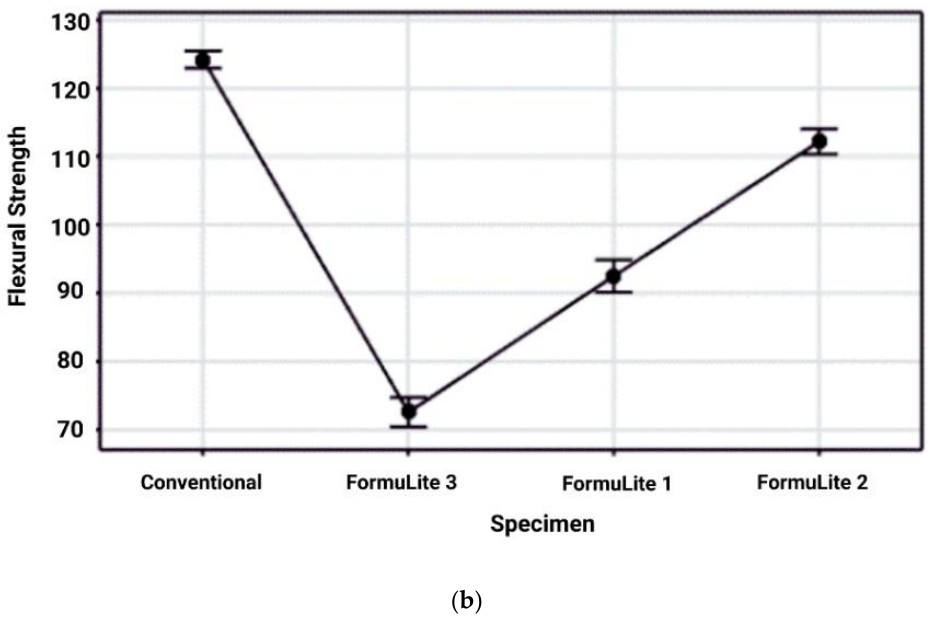
Figure 10. ( a ) Differences of means for flexural strength as per the ANOVA with Games–Howell comparison. ( b ) Interval plots of means of flexural strength versus test specimens.